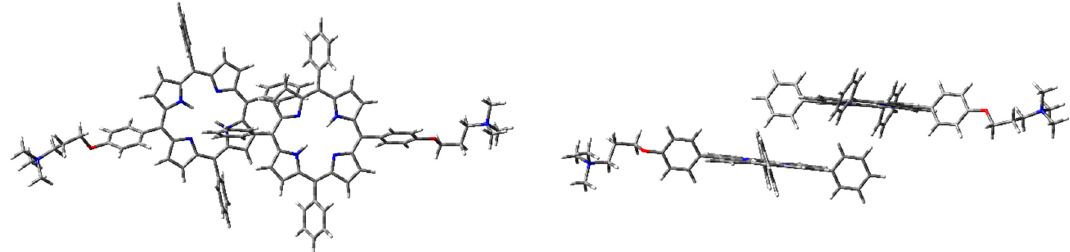
6-31G(d) basis set: front ( left ) and side ( right ) view.